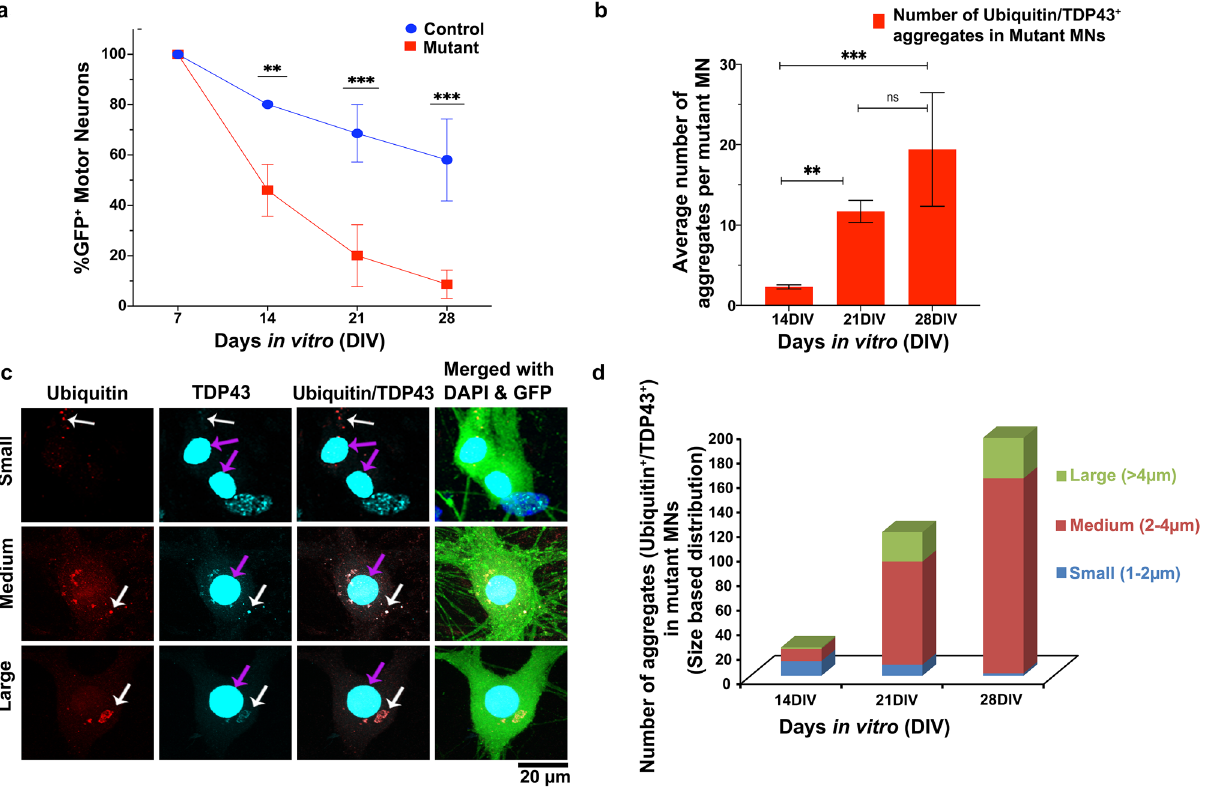
Figure 3. MN viability & quantification of cytosolic TDP-43 aggregates. ( a ) In vitro, quantification of MN viability showed a rapid decrease in the number of mutant MNs carrying TDP-43 mutation from 7 to 28DIV compared to that of control MNs without the mutation (p ≤ 0.001,n ≥ 3). All fluorescent intensities were normalized to 100% at 7 DIV. ( b ) Total number of Ubiquitin + /TDP-43 + aggregates per GFP + mutant MNs increased from 14 to 28DIV (n = 10,p ≤ 0.001) ( c ) Immunocytochemical staining of TDP-43 & Ubiquitin and their classification into different sizes in the mutant MNs (GFP + ). White arrows indicate the different sized cytosolic aggregates and pink arrows indicated the TDP-43 in the nucleus. ( d ) There is an increase in medium and large sized cytosolic TDP-43 + /Ubiquitin + aggregates in mutant MNs from 14 to 28DIV. P values: Non significant (ns) P > 0.05, *P ≤ 0.05, **P ≤ 0.01, ***P ≤